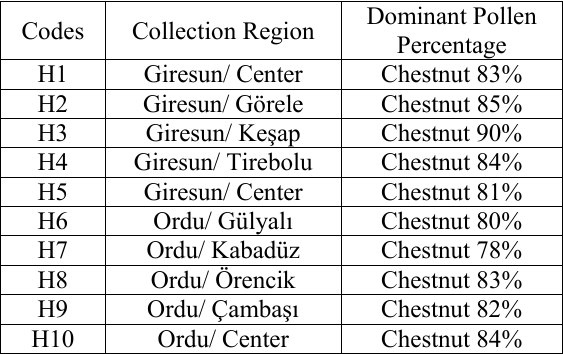
Table 1. Sample codes, origin and microscopic